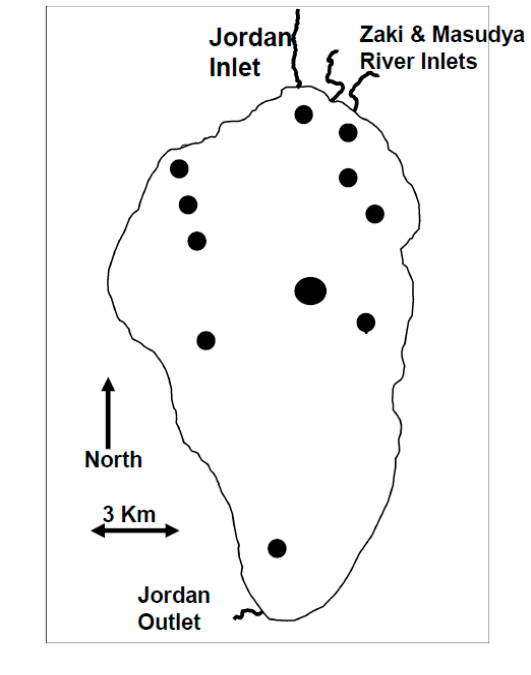
Figure 2. Lake Kinneret Map with Sampling Station distribution.